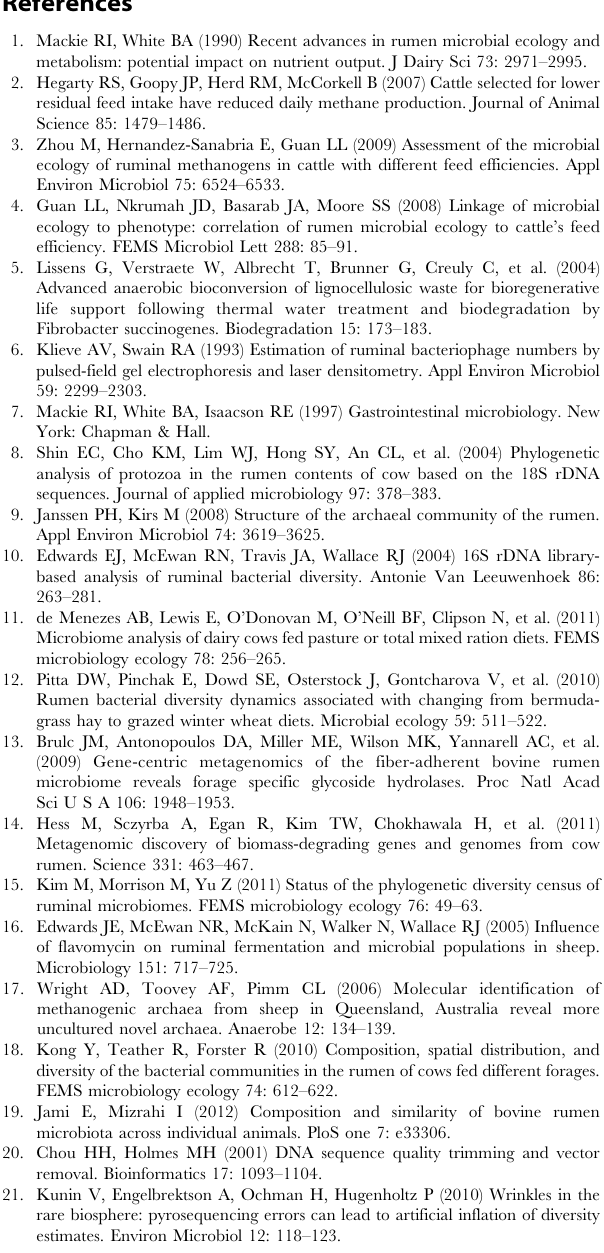
Table S2 Bacterial genera significantly differentiating liquid and solid fractions among 12 cows. (PDF) Table S3 Correlations among bacterial, archaeal, and fungal genera. (PDF) Table S4 Statistically significant cross-domain pairwise correlations between bacterial, archaeal and fungal classes. (PDF) Text S1 Supplemental methods describing animal breed, animal care, sample harvesting and processing, DNA purification, PCR conditions, and